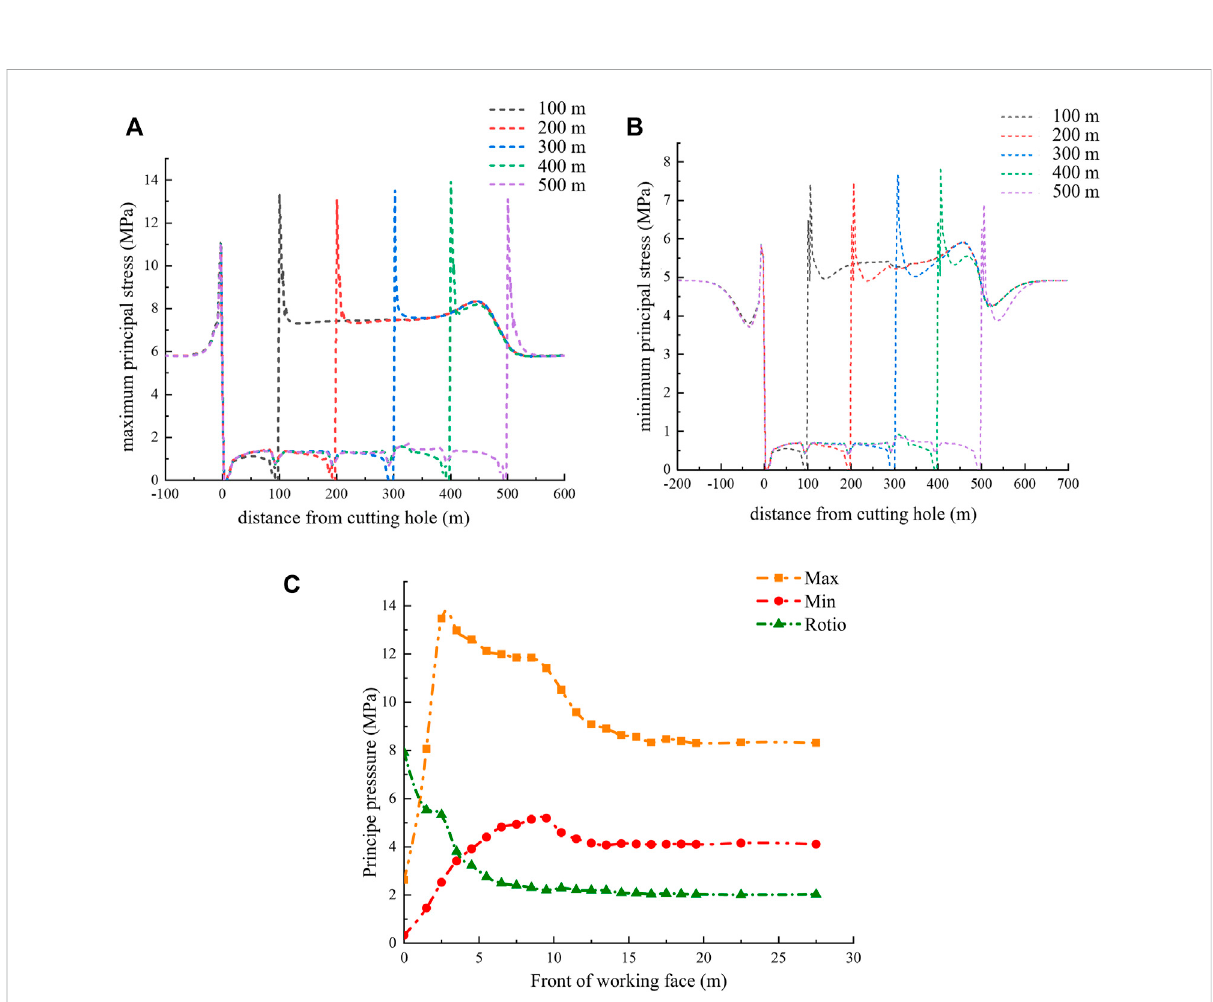
FIGURE 7 Distribution characteristics of the principal stress of surrounding rocks under different mining distances. (A) Maximum principal stress. (B) Minimum principal stress. (C) Maximum principal stress and minimum principal stress in